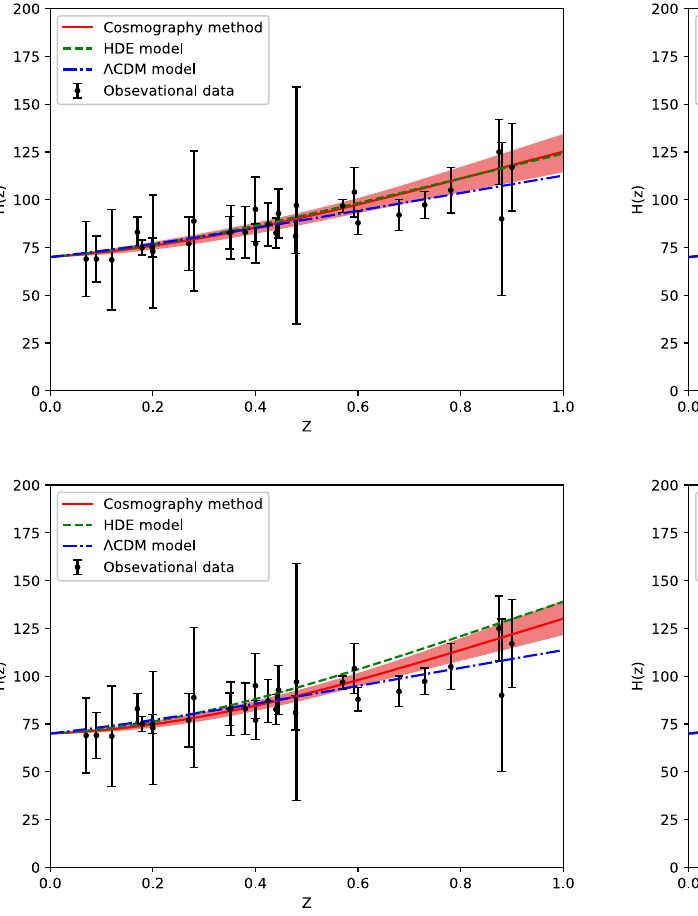
Fig. 4 Same as Fig. 3, but for z <